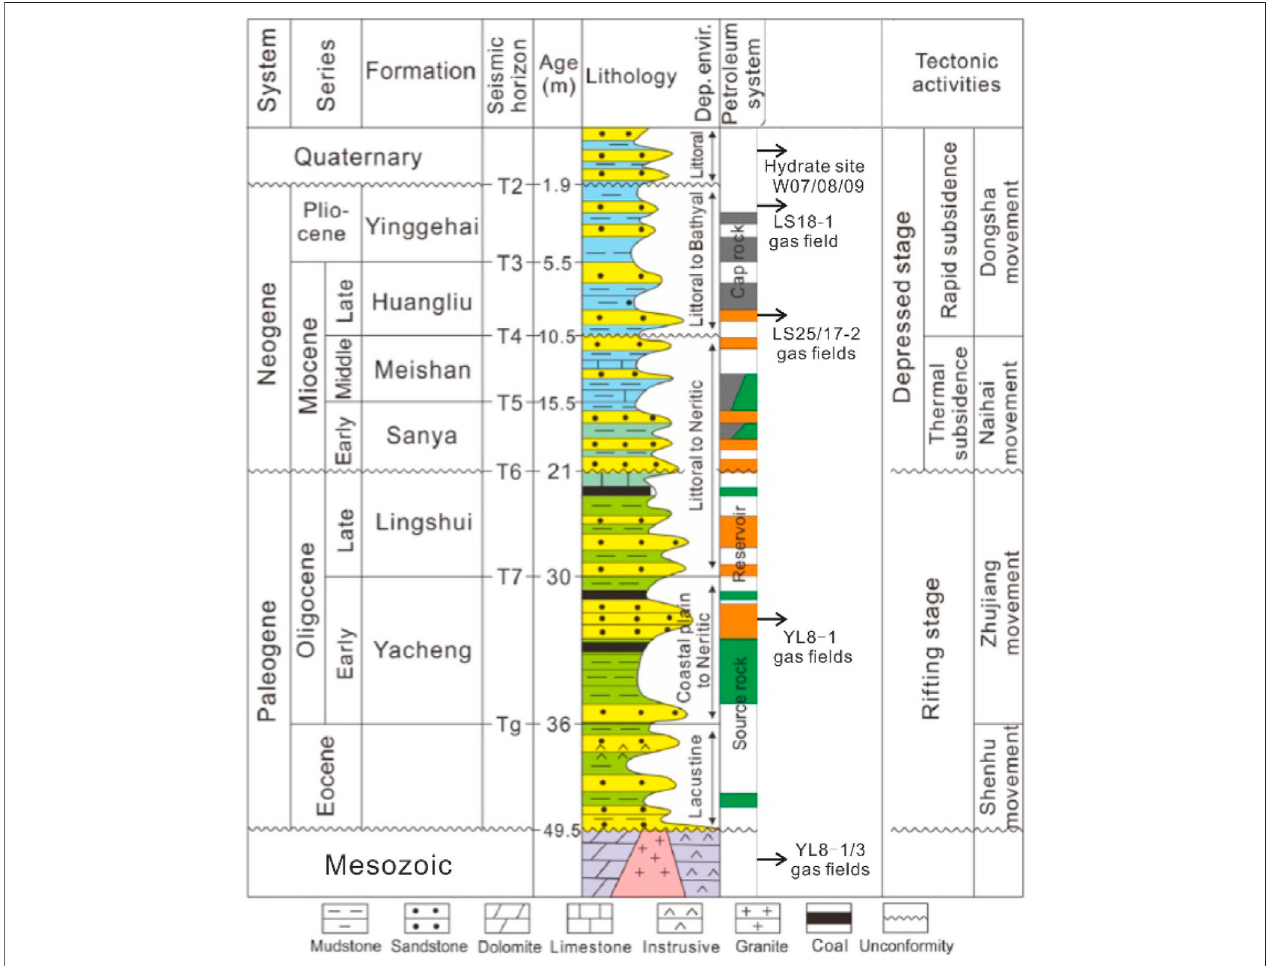
FIGURE 2 | Simpli fi ed stratigraphic column of the QDNB (modi fi ed after Su et al., 2018; Lai et al., 2021). Dep. Envir., depositional environment.